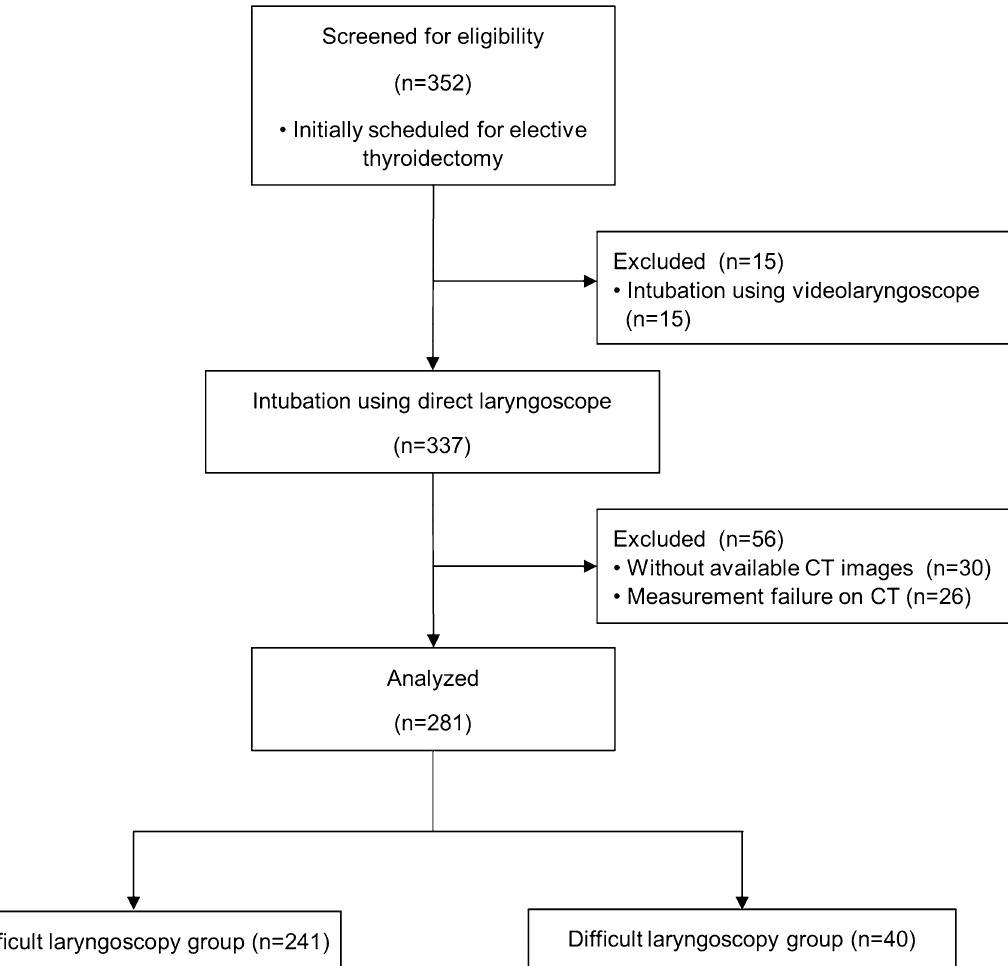
Figure 2. Flow chart of the selection of the study population. Among the 352 patients who were scheduled for elective thyroidectomy from April 2019 to March 2020 at our institution, 15 patients whose tracheas were intubated using video-laryngoscope are excluded. Among the remaining 337 patients, 30 patients without available computed tomography scan images (both axial and sagittal views) and 26 patients in which measurement of the vallecula was not possible are excluded. Finally, 281 patients with complete anterior neck soft tissue measurements and available records of Cormack-Lehane grade are included. One patient from the non-difficult laryngoscopy group is excluded from the area under the receiver operating characteristic curve calculation for neck AP diameter and the logistic regression analysis because of missing neck AP diameter data due to the impossibility of measurements owing to a tracheal deviation by